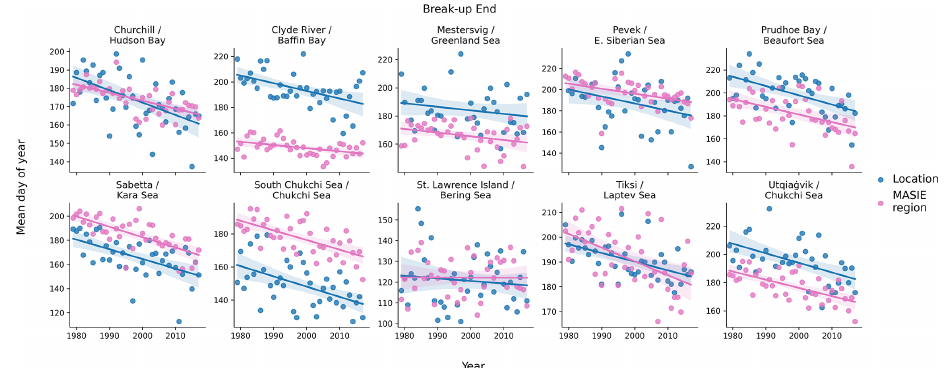
Figure 10. Yearly values (1979–2018) of the breakup end dates (shown as day-of-the-year numbers) for the coastal locations (blue) and the corresponding MASIE regions (pink). Date scales on the y axis vary among panels in order to optimize the display of data points. Linear regression lines are shown with the same color coding. In each panel, the upper line of header identifies the coastal location and the lower line identifies the MASIE region. All values are based on the modified J&E algorithms. Slopes and significance levels are listed in Tables S2 and S3.